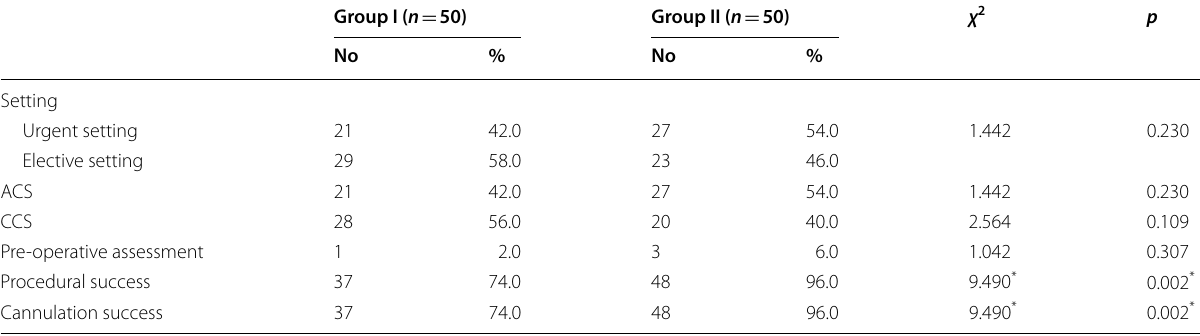
χ 2 Chi square test, p p value for comparing between the studied groups, Group I distal radial artery, Group II conventional radial artery *Statistically significant at p ≤